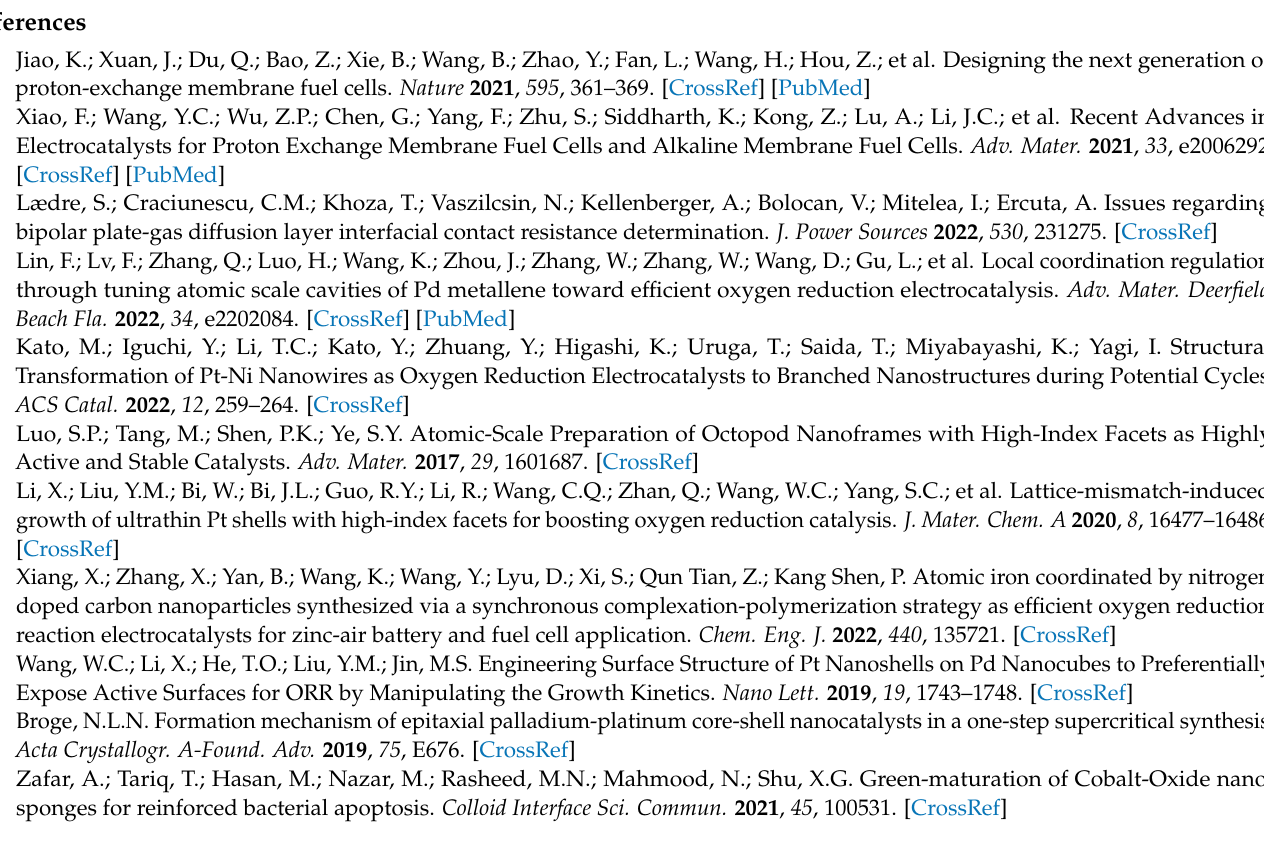
particle size distribution; Figure S3. TEM image of Pd-Pt-Ni Octa3 and responding particle size distribution; Figure S4. TEM images after 10 k cycles of Pd-Pt-Ni Octa1. Table S1. Pt, Pd and Ni Table S2. The relevant Lattice parameter correlated to Pt(111) plane (nm) and calculated strain of Pt, Pd-Pt-Ni Octa1, Pd-Pt-Ni Octa2 and Pd-Pt-Ni Octa3; Table S3. When the gas phase water was at 0.035 bar and T = 298 K, the gas phase water was in equilibrium with liquid water. The following data are calculated at this equilibrium state; Table S4. Gibbs free energy in a four-electron reaction, while product1 stands for 2 (H + + e − ) + H 2 O and product2 stands for H + + e − + H 2 O, U = 0 V; Table S5. In the four-electron reaction, the Gipps free energy of Pd-Pt-Ni Octa1 (111) in ORR each step at 1.23V is as follows: ∆ G(H 2 O) = 0, ∆ G(*OH) = 1.12–1.23, ∆ G(*O) = 1.81–2*1.23, ∆ G(*OOH) = 4.09–3*1.23, ∆ G(O 2 ) = 4.8–4*1.23. In the four-electron reaction, the Gipps free energy of Pt/C in ORR each step at 1.23V is as follows: ∆ G(H 2 O) = 0, ∆ G(*OH) = 1.05–1.23, ∆ G(*O) = 1.71–2*1.23, ∆ G(*OOH) = 4.02–3*1.23, ∆ G(O 2 ) = 4.8–4*1.23; Table S6. Performance of Pd-Pt-Ni Octa1, Pd-Pt-Ni Octa2 and Pd-Pt-Ni Octa3 catalyst compared to